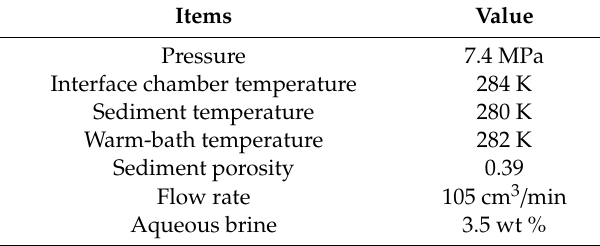
Table 1. Experiment conditions in this